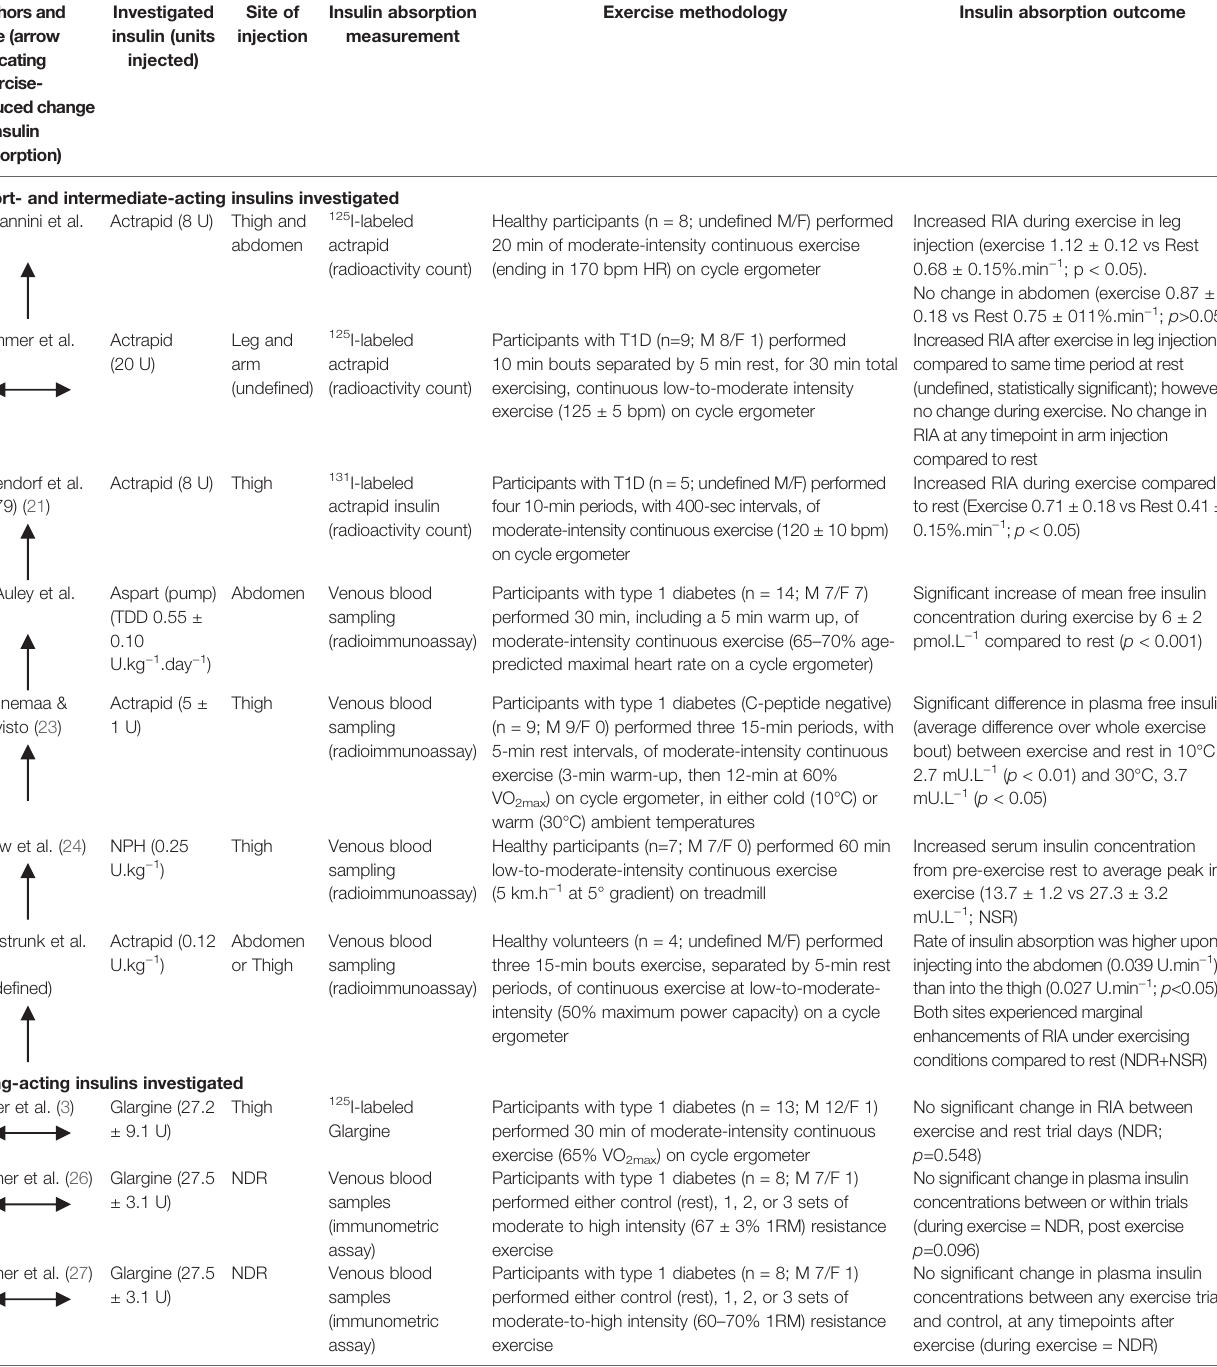
TABLE 2 | Randomized controlled trials investigating the effect of exercise compared to rest on insulin absorption in people with type 1 diabetes or healthy